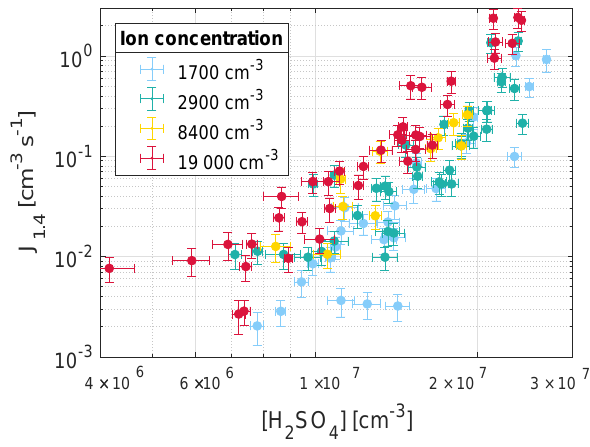
Figure 5. Nucleation rates as a function of sulfuric acid concen- tration and ion concentration. The error bars represent 1 σ standard deviation on the [H 2 SO 4 ] and the 95% confidence interval on the nucleation